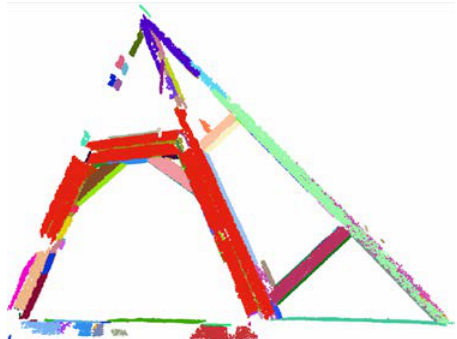
Figure 8: Segments of different beams; Different colours represent different segment IDs